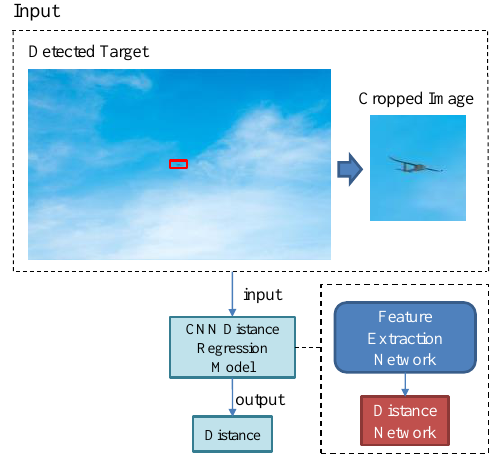
Figure 6. The architecture of the convolutional neural network (CNN) distance estimation system.